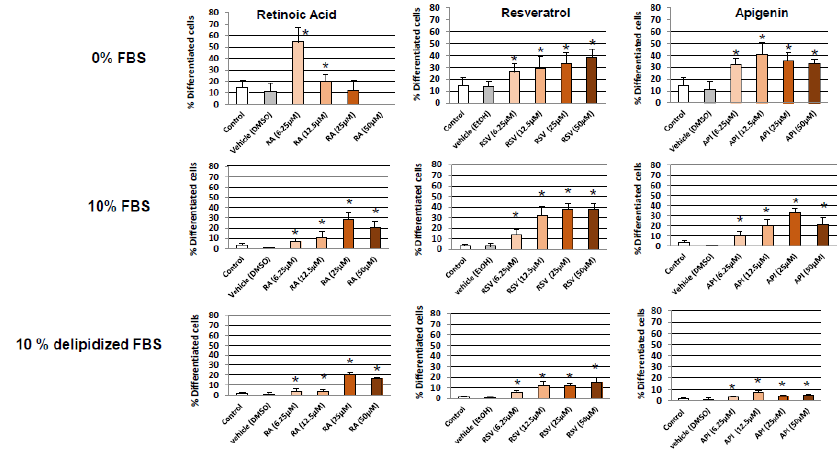
Figure 2. Quantification of neuronal differentiation induced by resveratrol and apigenin on N2a cells. Murine neuronal N2a cells previously cultured for 24 h in conventional cultured medium were further cultured for 48 h in medium without or with 10% FBS in the absence or in the presence of retinoic acid (RA: 6.25–50 µM) used as positive control for the induction of neuronal differentiation, or with polyphenols: resveratrol (RSV: 6.25–50 µM) and apigenin (API: 6.25–50 µM). Control cells were cultured in medium without and with 10% FBS. Two vehicle controls were realized: EtOH used with RSV, and DMSO used with RA and API. The percentages of differentiated cells include cells with dendrites, axons and dendrites + axons; these percentages were determined by phase contrast microscopy. Each value is the mean ± standard deviation (SD) of four independent experiments. An ANOVA test followed by a Mann-Whitney test were used. p values of 0.05 or less were considered as statistically significant. * comparison between control (untreated cells), vehicles (DMSO, Ethanol (EtOH)), and RSV, API and RA; no difference between control/vehicles (DMSO, EtOH) was